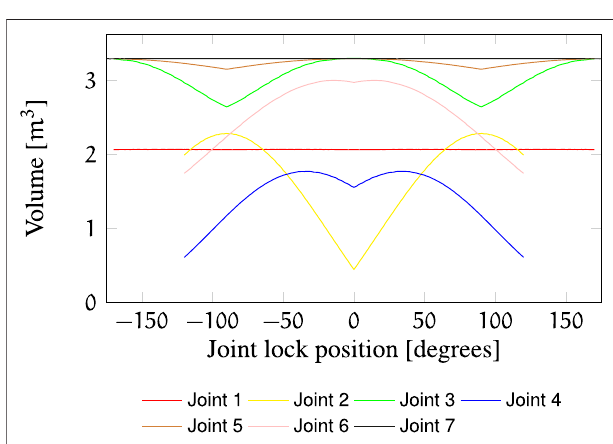
FIGURE 7 | Post-failure workspace volume of W j , l as a function of l . The nominal failure-free volume is 3.292 m 3 .